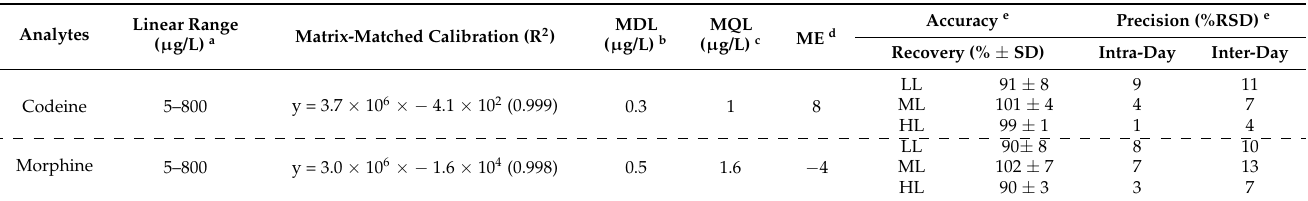
Table 2. Validation parameters for the proposed method based on µ SPEed ® followed by GC-MS for the quantification of opium alkaloids in poppy seed